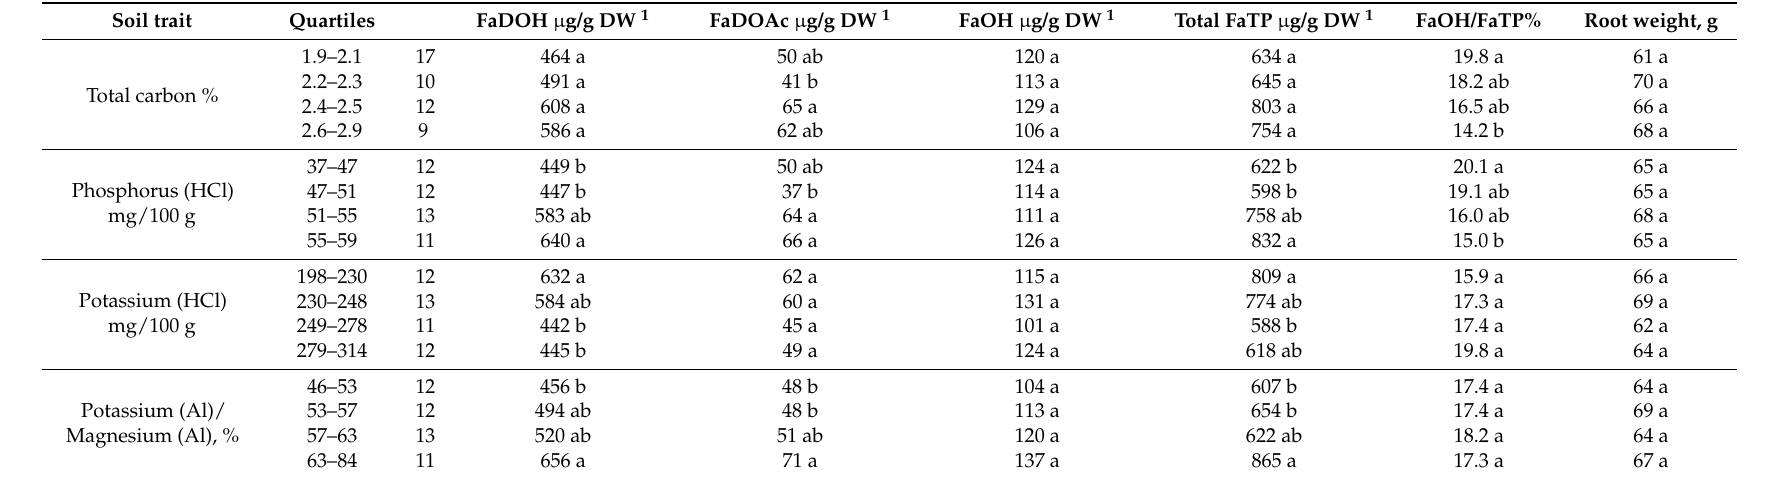
Table 5. Quartiles of soil parameters in relation to FaTP concentrations and root weight at harvest on 10 September. n = 48. Means within the same section of a column followed by different letters are significantly different according to one-way ANOVA with Duncan’s post hoc test ( p <